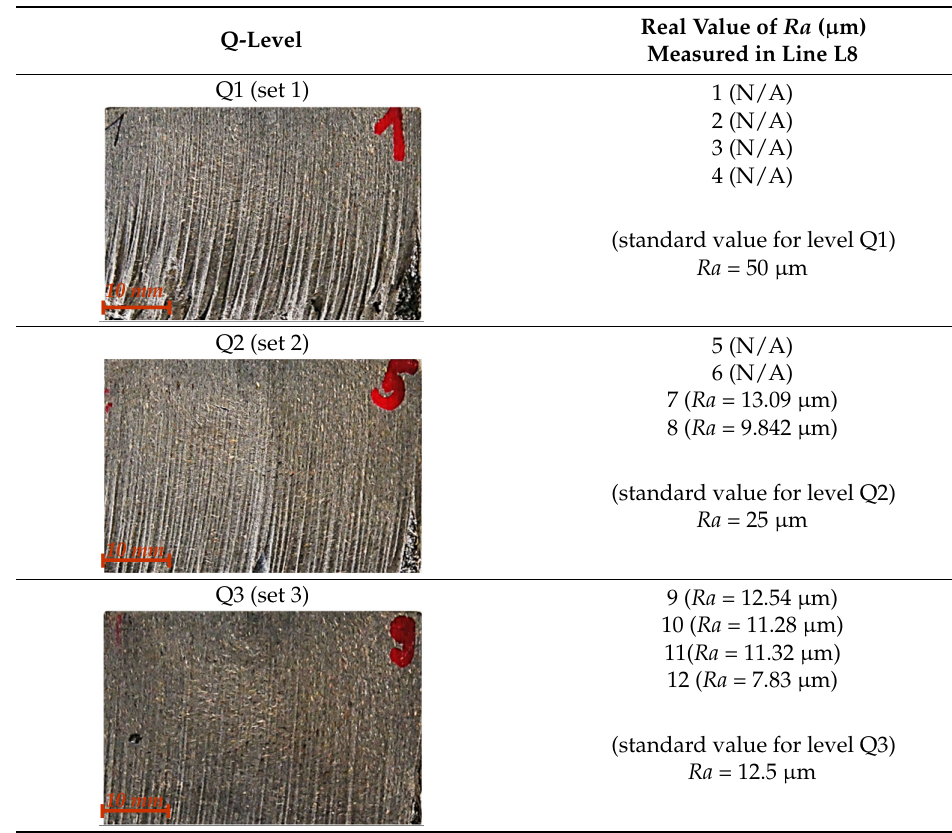
Table 3. Examined samples, real values of Ra in line L8, and the standard value for the presented QX